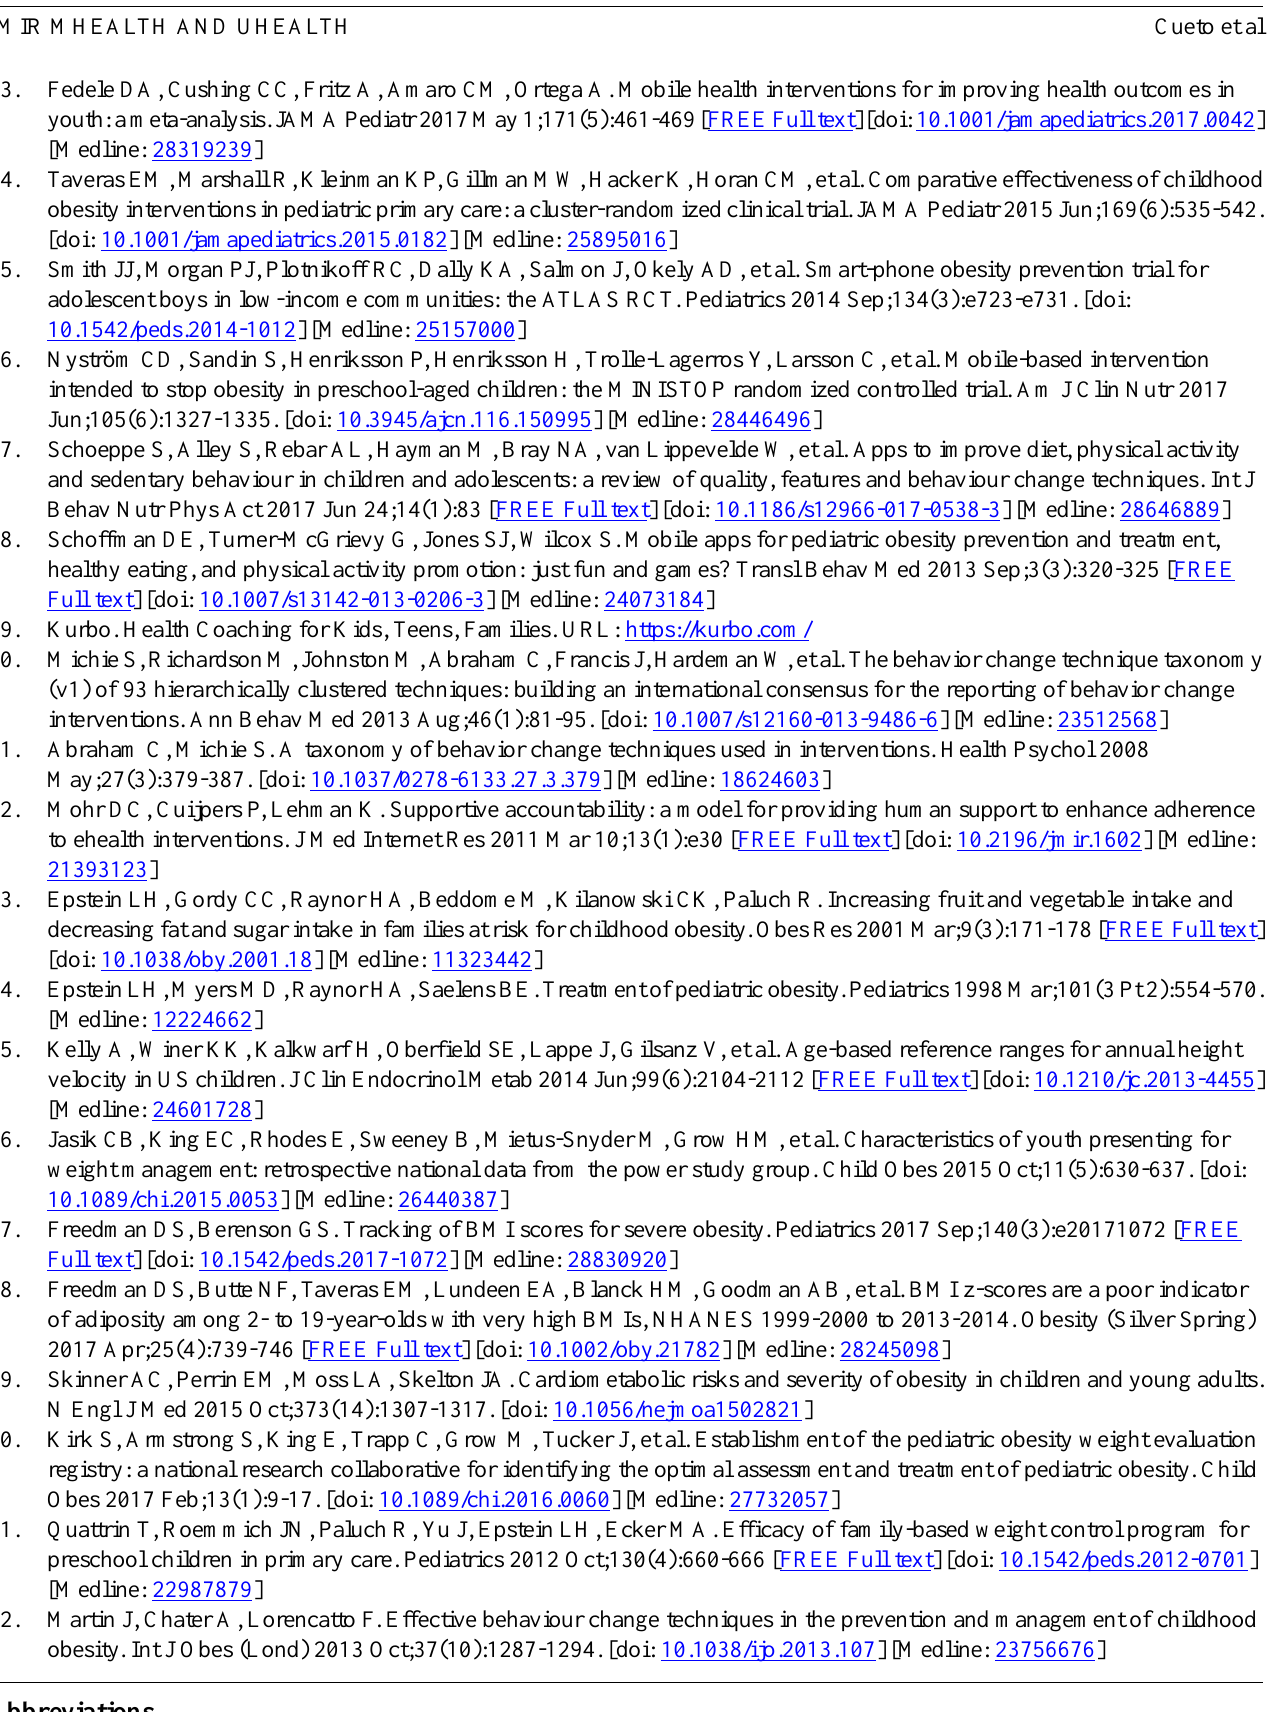
%BMIp95: BMI as percentage of the 95th percentile BCT: behavior change